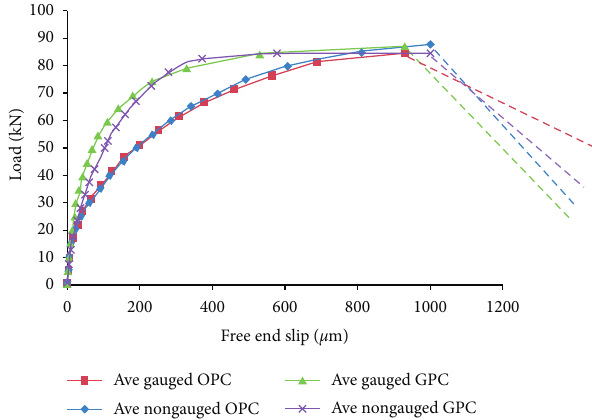
Figure 11: Bond-slip curves of ribbed bar-reinforced GPC and OPC.